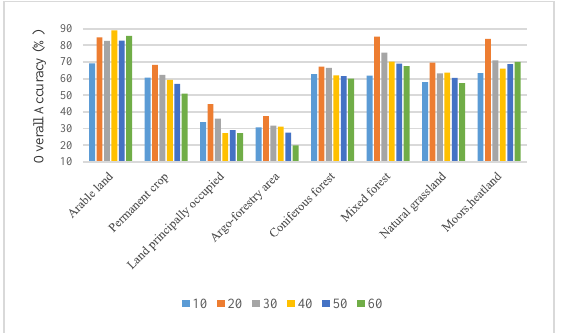
Figure 9. Average of overall accuracy obtained from the second experiment (with fine-tuning the parameters) on Sentinel-2 image for each class with ResNet 152 network.